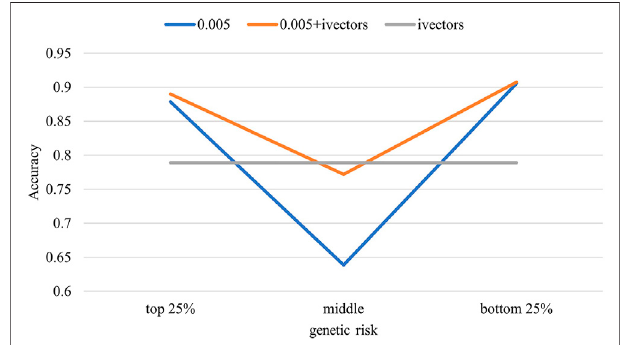
FIGURE 5 | Strati fi ed population accuracy using different biomarkers. The test samples were divided into three groups according to their predicted polygenic risk scores (PRSs). Accuracies were calculated for the three groups